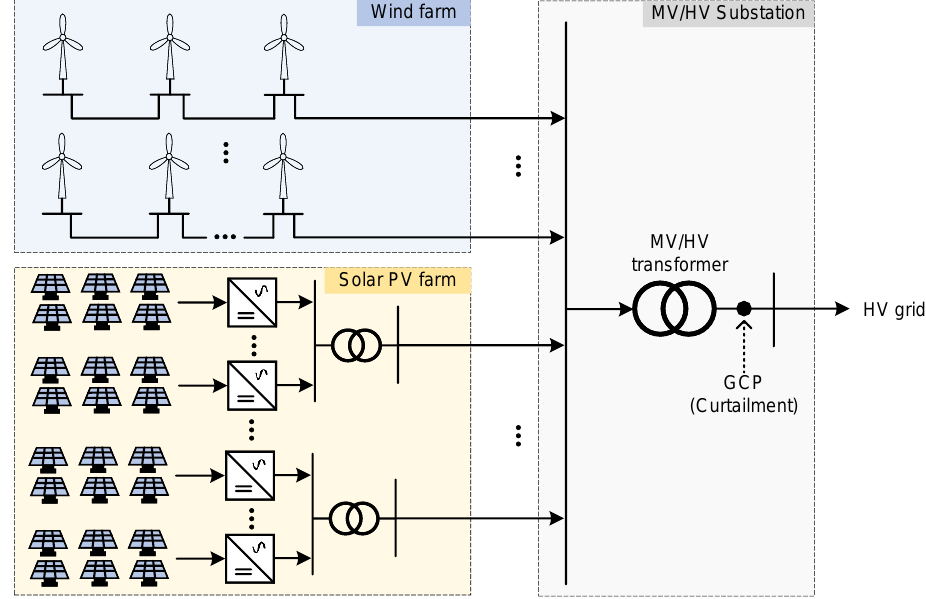
Figure 9. The structure of considered large-scale hybrid wind–PV